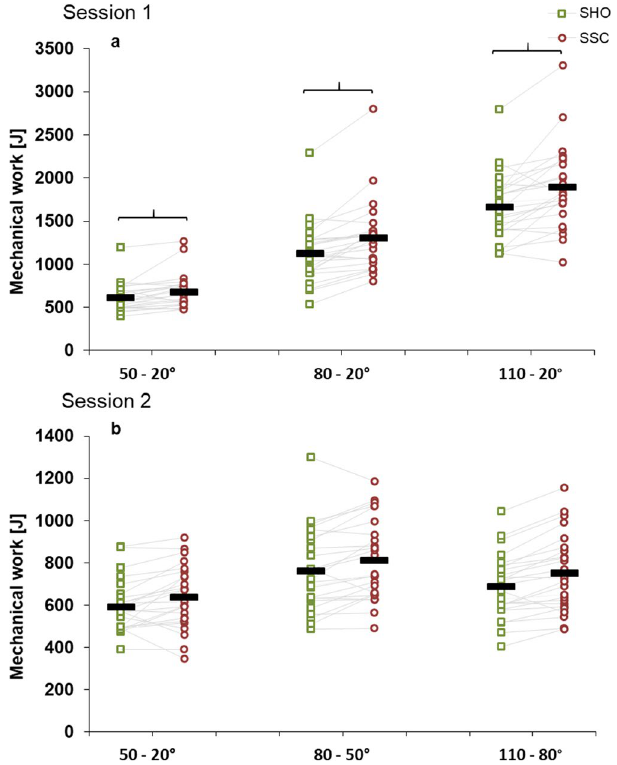
Figure 4. Mean (n = 25, thick horizontal line) (and mean of each individual subject) values of mechanical work during shortening in session 1 with varying SHO- and SSC-magnitudes ( a ) and session 2 with varying muscle–tendon unit lengths ( b ). Green squares represent shortening-hold conditions (SHO), whereas red circles represent stretch–shortening conditions (SSC). In the SSC condition the shortening phase was preceded by the corresponding stretch phase. Braces indicate significant ( p < 0.05) differences between SSC and the corresponding SHO